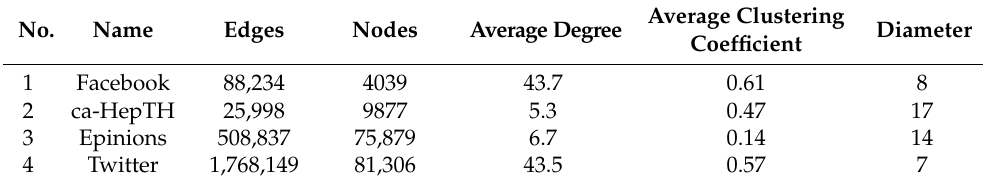
Table 1. The description of